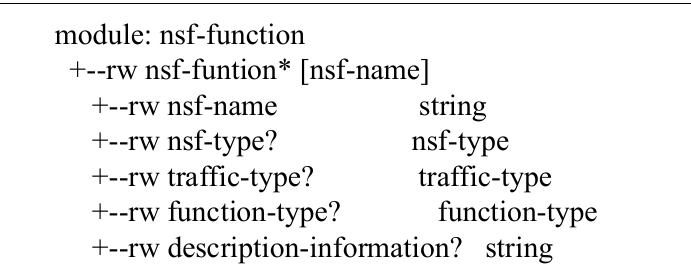
Figure 8. Information Model for Feedback of NSF Capability.